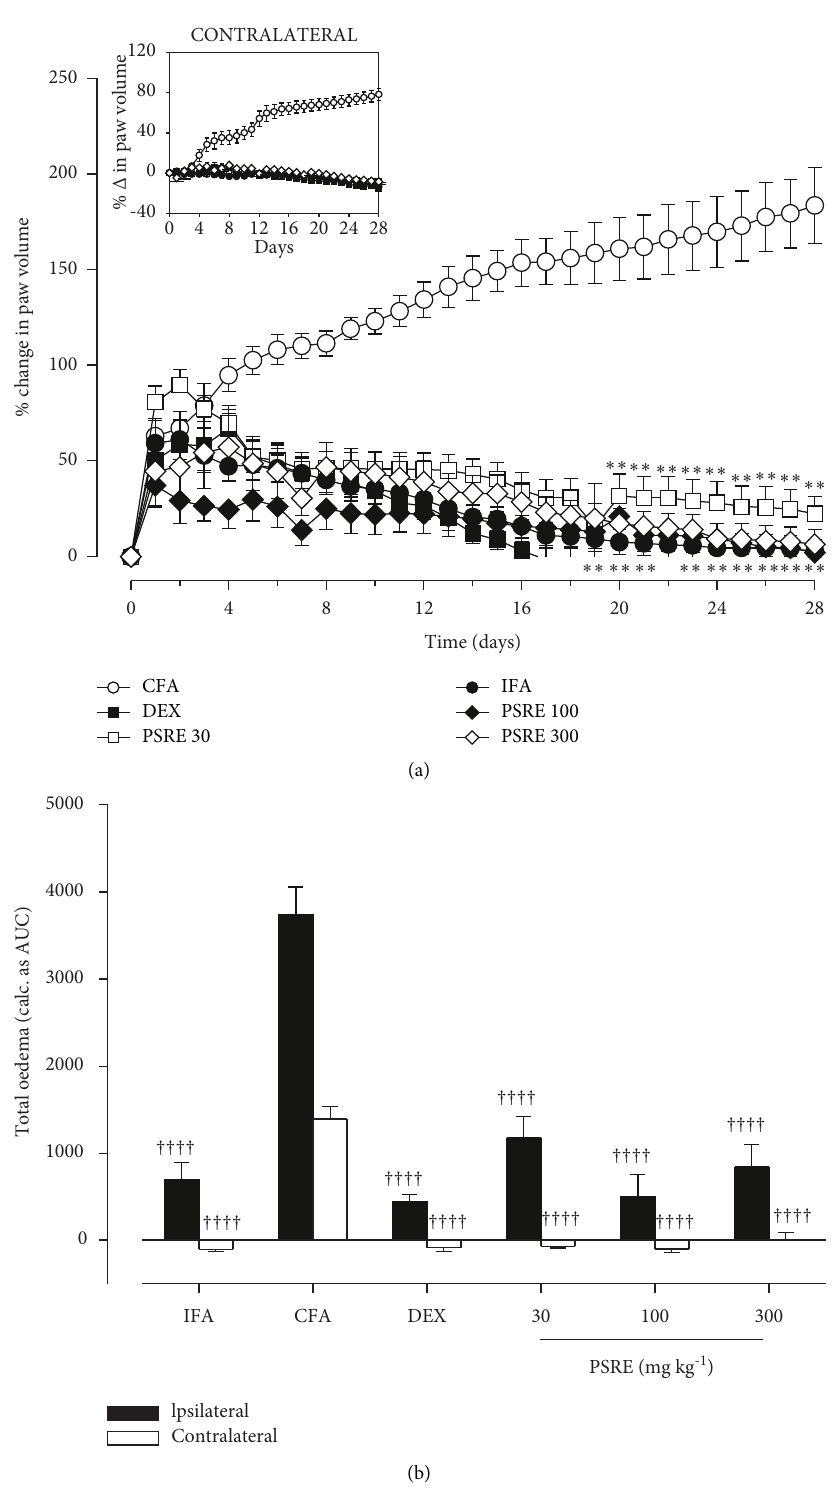
Figure 1: Effect of prophylactic administration of PSRE and dexamethasone on time-course curves (a) and total paw edema (b) in adjuvant- induced arthritis in rats. Data is presented as Mean Tukey’s multiple comparison test). †††† P